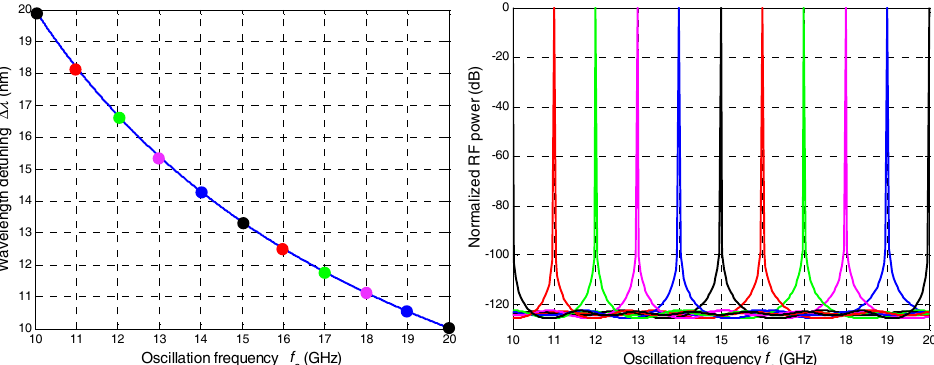
Figure 11. ( Left ) Oscillation frequency versus wavelength detuning for a vernier multi-cavity optoelectronic oscillator based on a seven-core heterogeneous fiber for τ go = 5 ns/m, D = 1 ps/(km · nm) and L = 5 km; and ( Right ) corresponding oscillation spectrum for the different wavelength detuning positions [55].